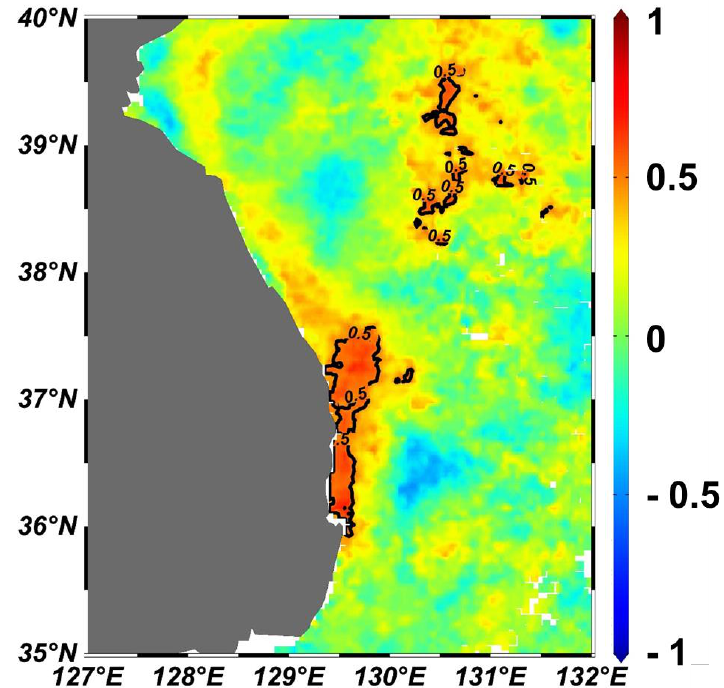
Figure 8. Horizontal correlation coefficient distribution between chlorophyll- a in February and stratification index in February. Black lines represent significant levels: p < 0.01).